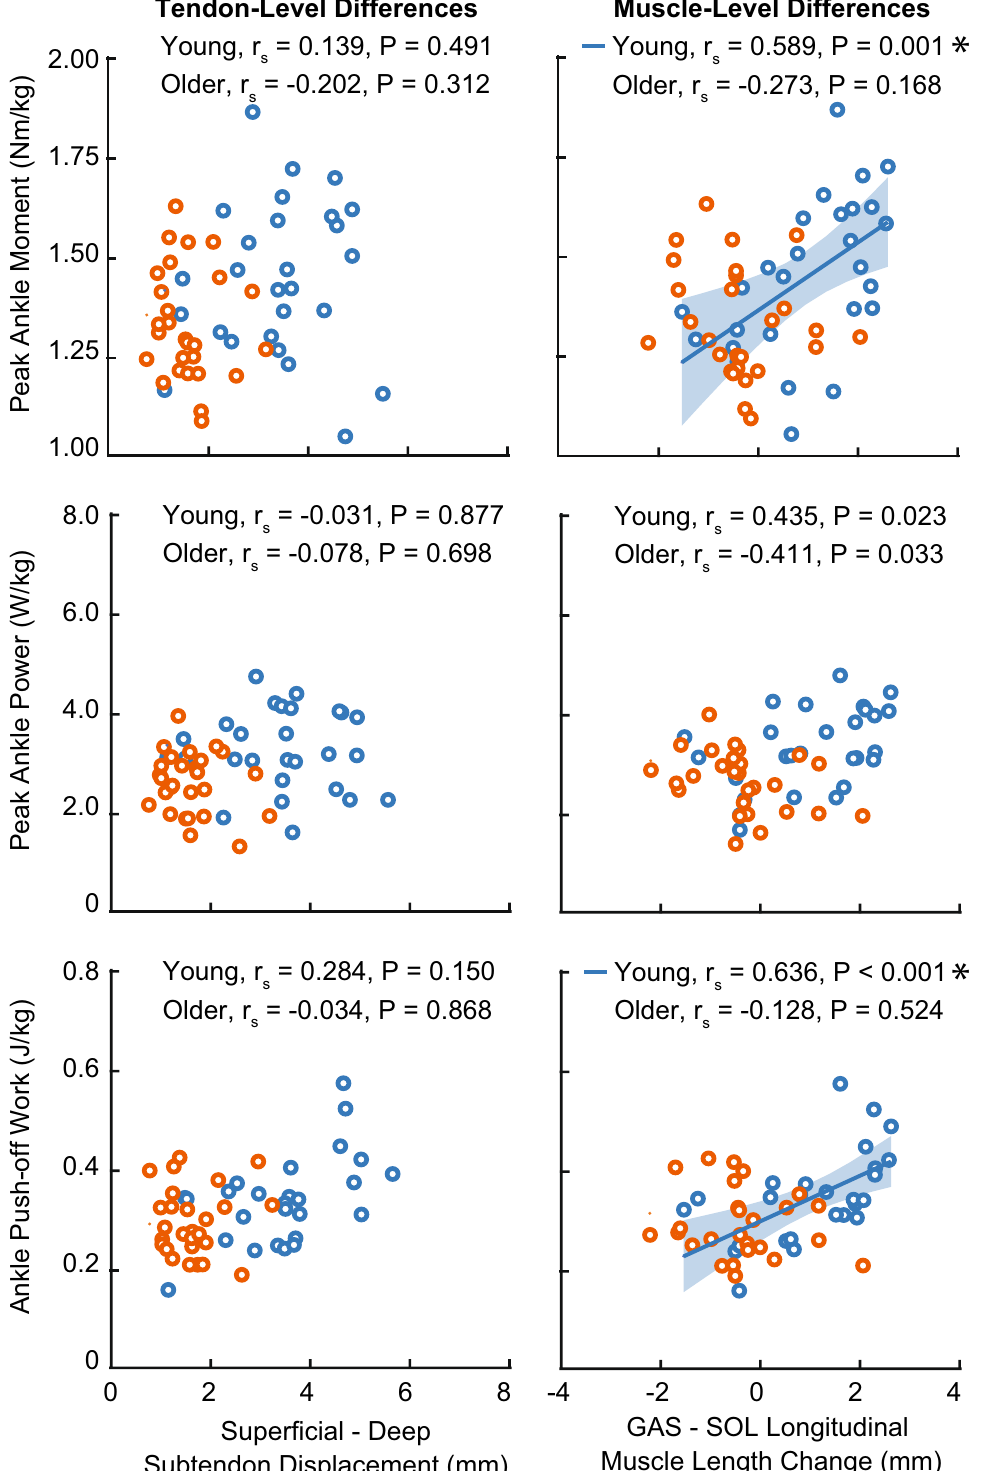
Figure 4. Spearman’s correlations between push-off intensity (i.e., peak ankle moment, peak ankle power, and ankle push-off work) and (left) Achilles tendon non-uniformity (superficial—deep subtendon tissue displacement) and (right) triceps surae muscle length change heterogeneity (medial gastrocnemius (GAS)– soleus (SOL) longitudinal muscle length change) during conditions that alter the mechanical demand for forward propulsion via horizontal forces. Individual data points for young and older adults represented by blue and orange open circles, respectively. Single asterisks (*) represent significant correlations (P <